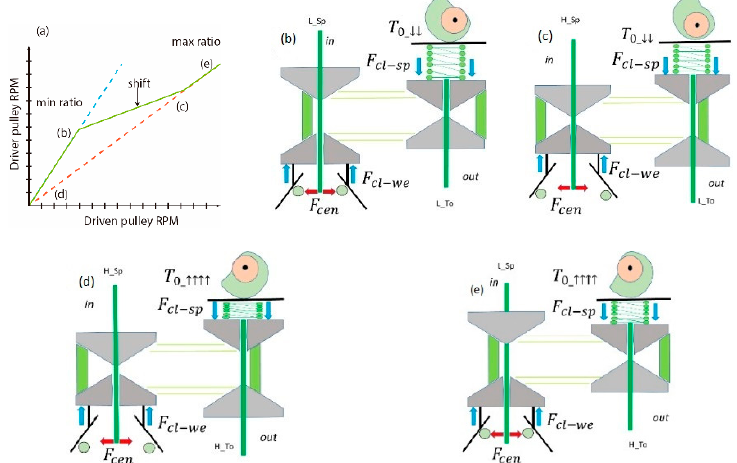
Figure 7. ( a ) Possible operational situations: low speed, high torque ( b ); high speed, high torque ( c ); low speed, low torque ( d ); high speed, low torque ( e ).